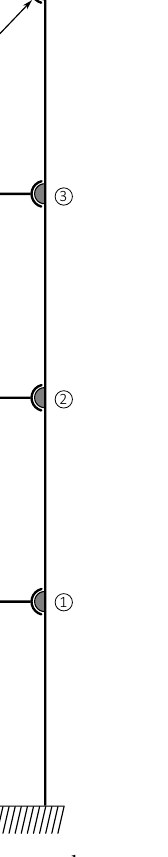
Figure 2. The four-story shear structure used for numerical verification. The control aim is to mitigate horizontal displacements of the reference point (RP) under random seismic excitation. Table 1. Selected natural frequencies and damping ratios: for the structure shown in Figure 2 with all its controllable nodes in the “off” state and for the corresponding structure with all nodes rigid. All Nodes “off” (Unlocked Hinges) All Nodes Rigid Mode No. Natural Freq.